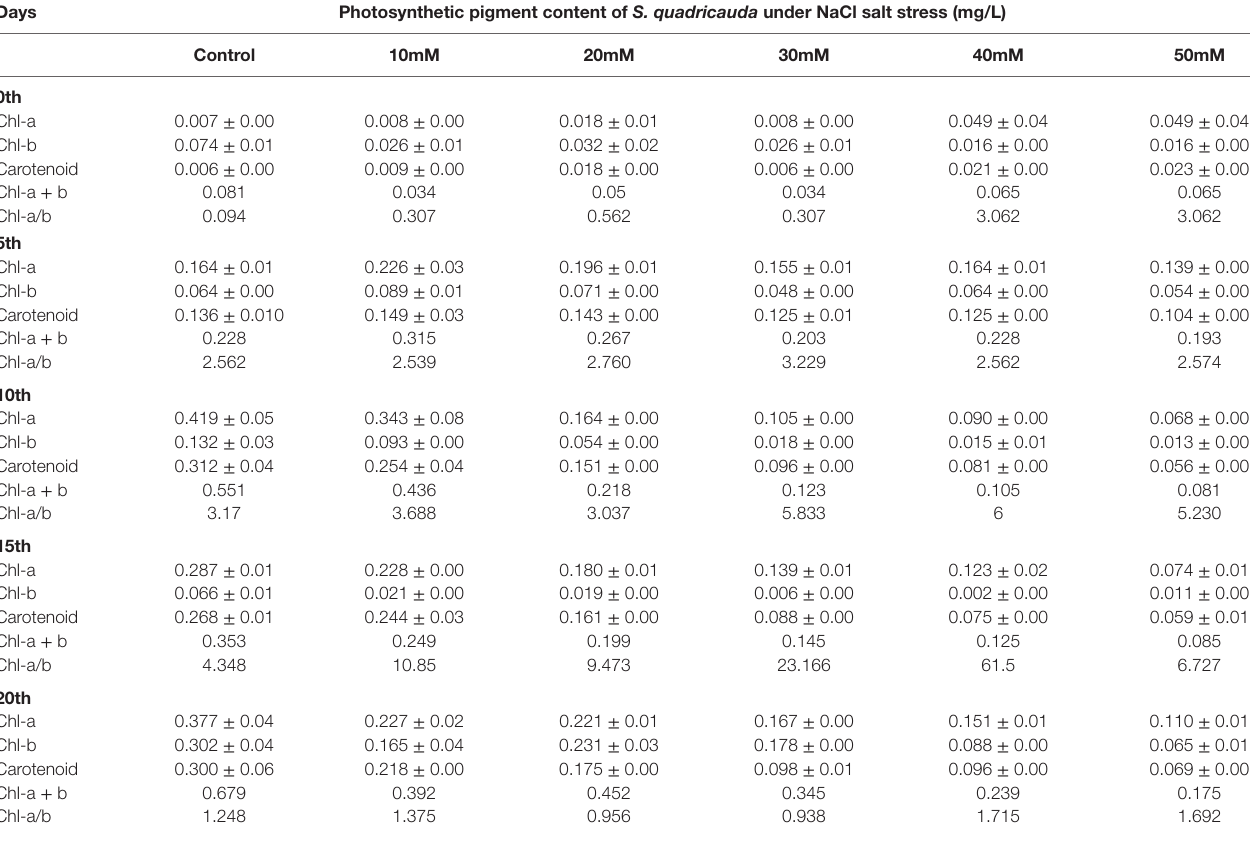
TaBle 3 | Photosynthetic pigment content of S. quadricauda under salt stress. Days Photosynthetic pigment content of S. quadricauda under nacl salt stress